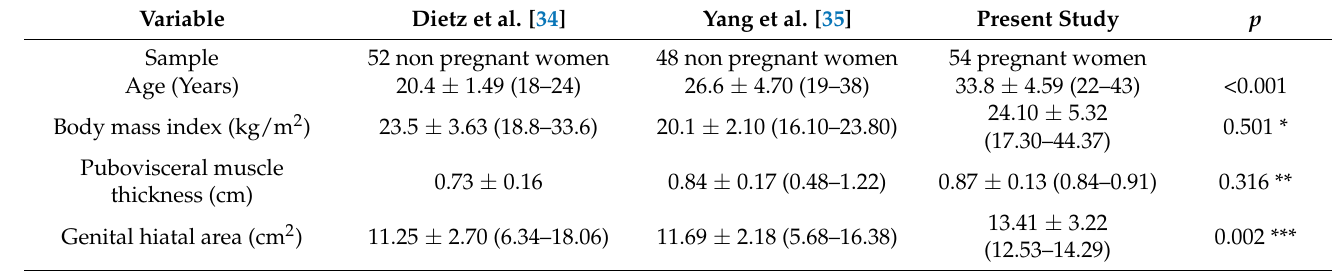
Table 3. Patient sonographic and demographic data of the pelvic floor in tow series with different stage. Data are presented as mean ± SD (range). Comparison between these groups from the summary of data (mean, SD and sample size). * p value < 0.001 comparison with Yang et al. [35] study. ** p value < 0.001 comparison with Dietz et al. [34] study. *** p value < 0.001 comparison with Dietz et al. [34]